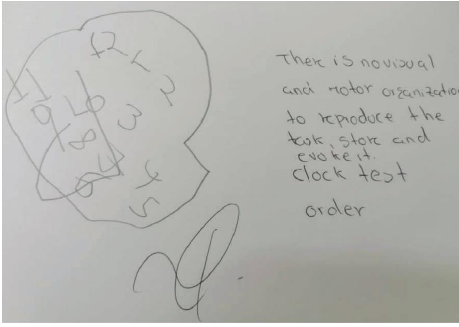
Figure 4: Clock test on